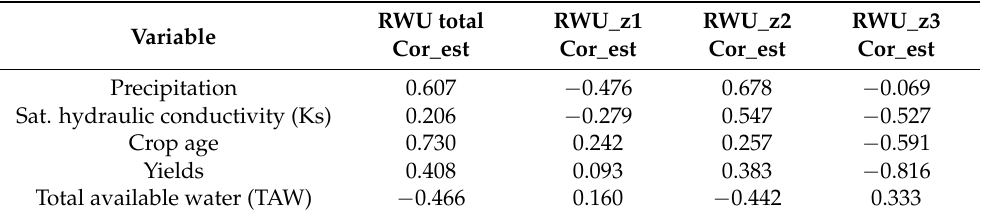
Table 3. The variable correlations with root water uptake